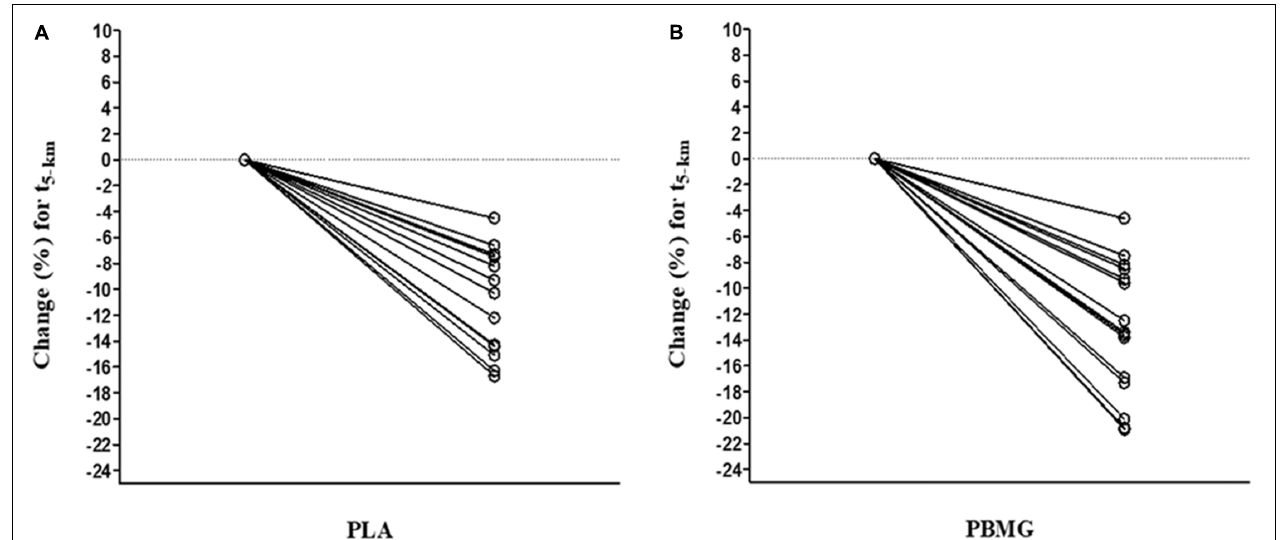
FIGURE 2 | Individual change of time to complete 5 km (% change of t 5 − km ) in PLA group and PBMG. (A) Individual change in the PLA group. (B) Individual change in the PBM group ( n = 15 each group).